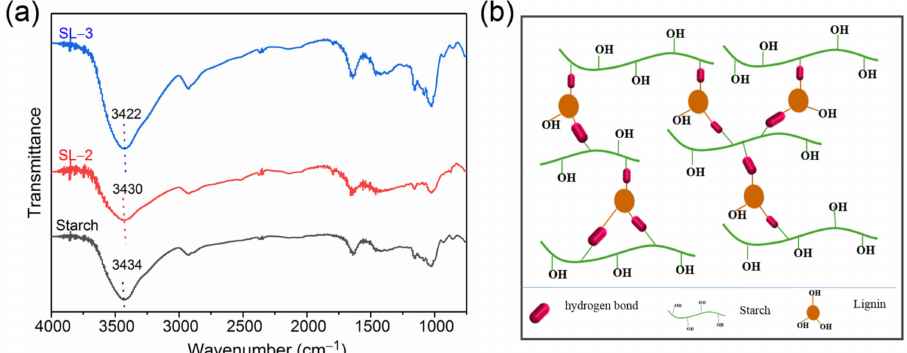
Figure 2. FTIR spectra ( a ) of starch film and SL composite films incorporating 2% and 3% LNPs, and schematic illustration ( b ) of the interaction between starch matrix and LNPs.